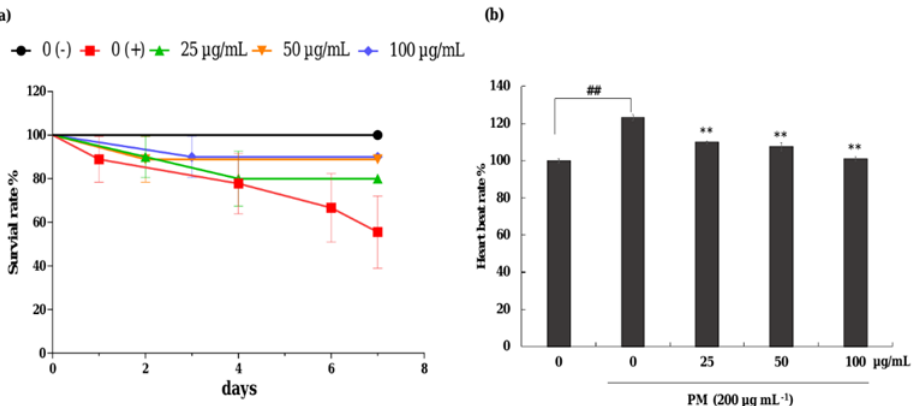
Figure 6. Effects of CRHF2 on PM-induced alterations in survival rate and heart beat rate of zebrafish. ( a ) survival rate, ( b ) heartbeat rate. Experiments were triplicated (n = 3). Results are represented as mean ± SD; ** p < 0.01. (# denotes significance compared to control while * represents significance compared to PM treated group 0 (+)).